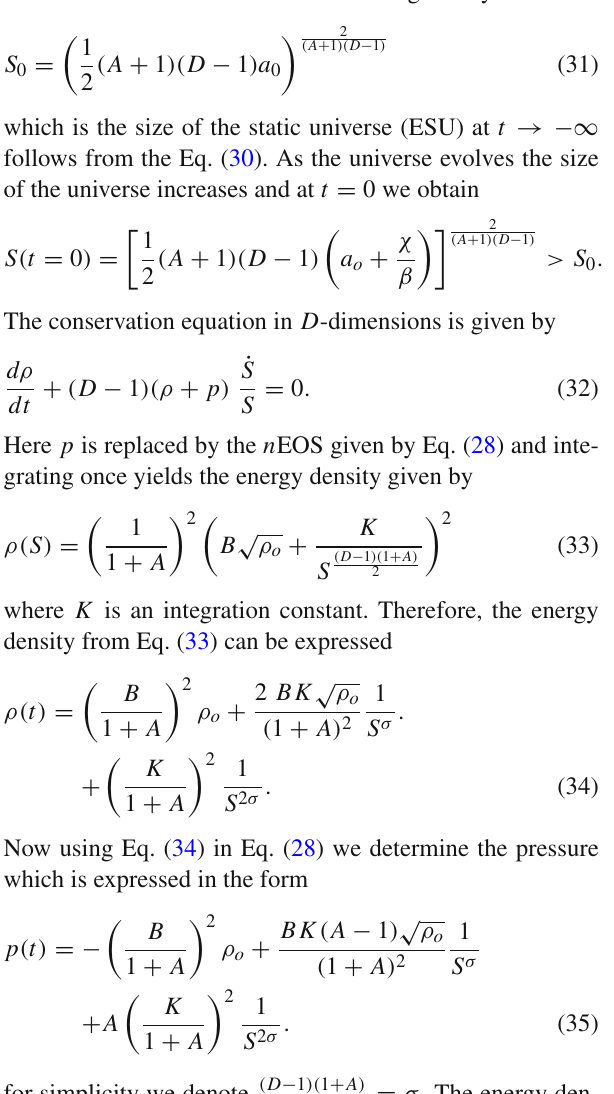
Table 1 Composition of universal matter with A , ω 2 corresponds to exotic matter (EM), σ = ( D − 1 )( A + 1 )